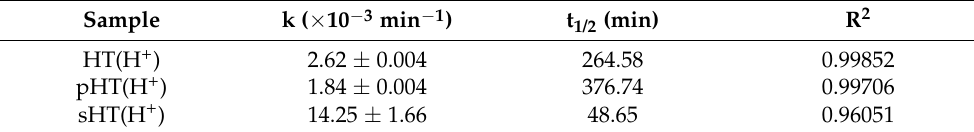
Table 3. Kinetic constant, R 2 and t 1/2 values of the fitting for each